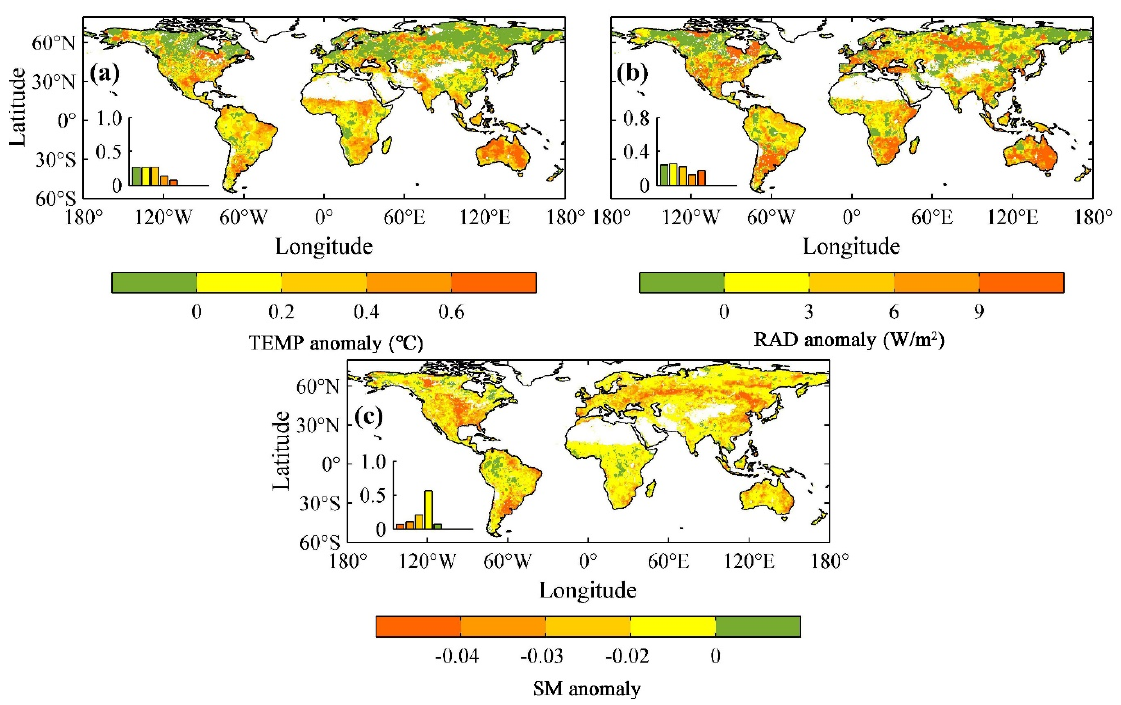
Figure 11. Changes in climate factors during the drought period. ( a – c ) show the anomalies of TEMP (Temperature), RAD (Radiation), and SM (soil moisture), respectively, during drought periods compared to those in non-dry periods.